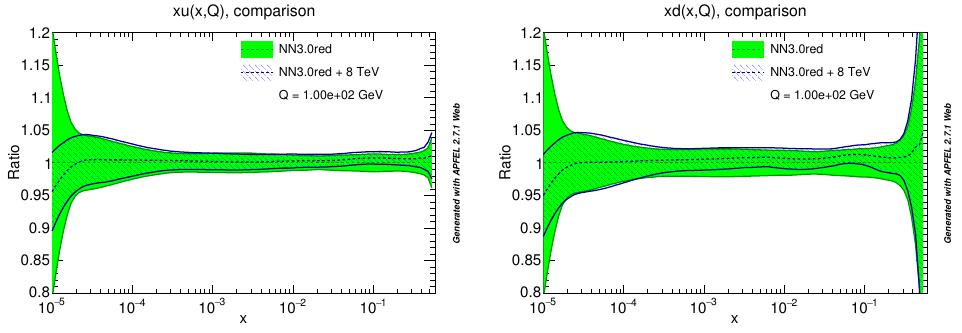
Figure 15 . Impact of the inclusion of the 8 TeV p Z distributions.